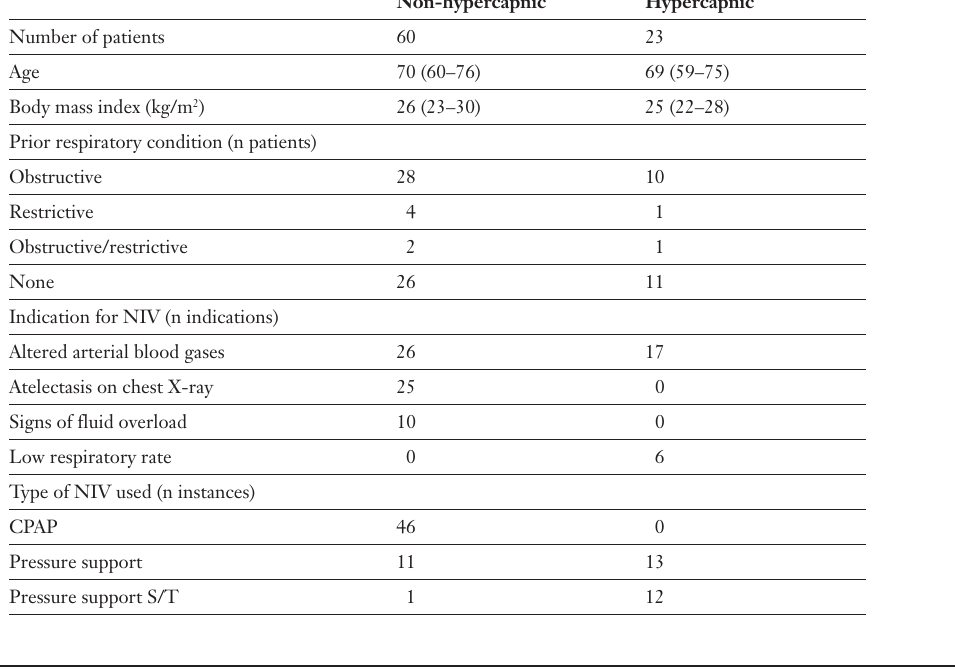
Results of the initial application of